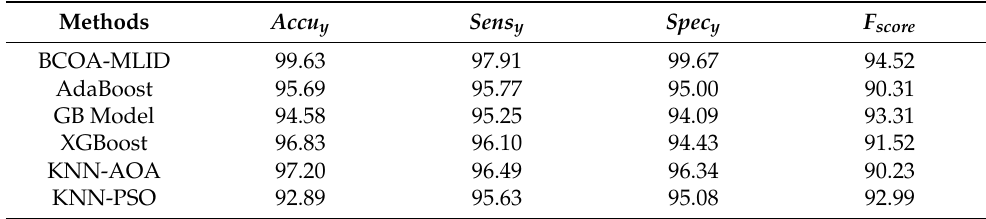
Table 4. Comparative outcome of the BCOA-MLID approach with recent systems